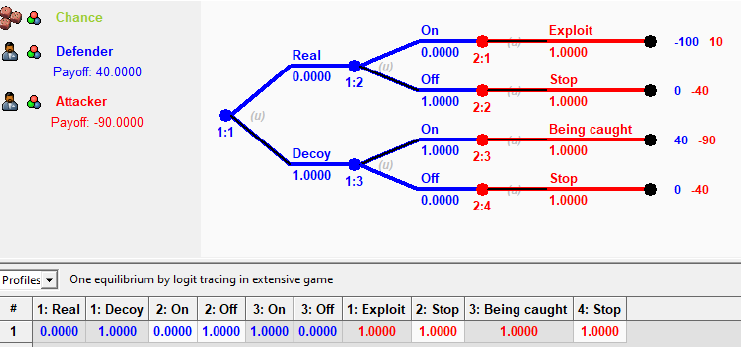
Figure 7. Results of the dominance for N 1